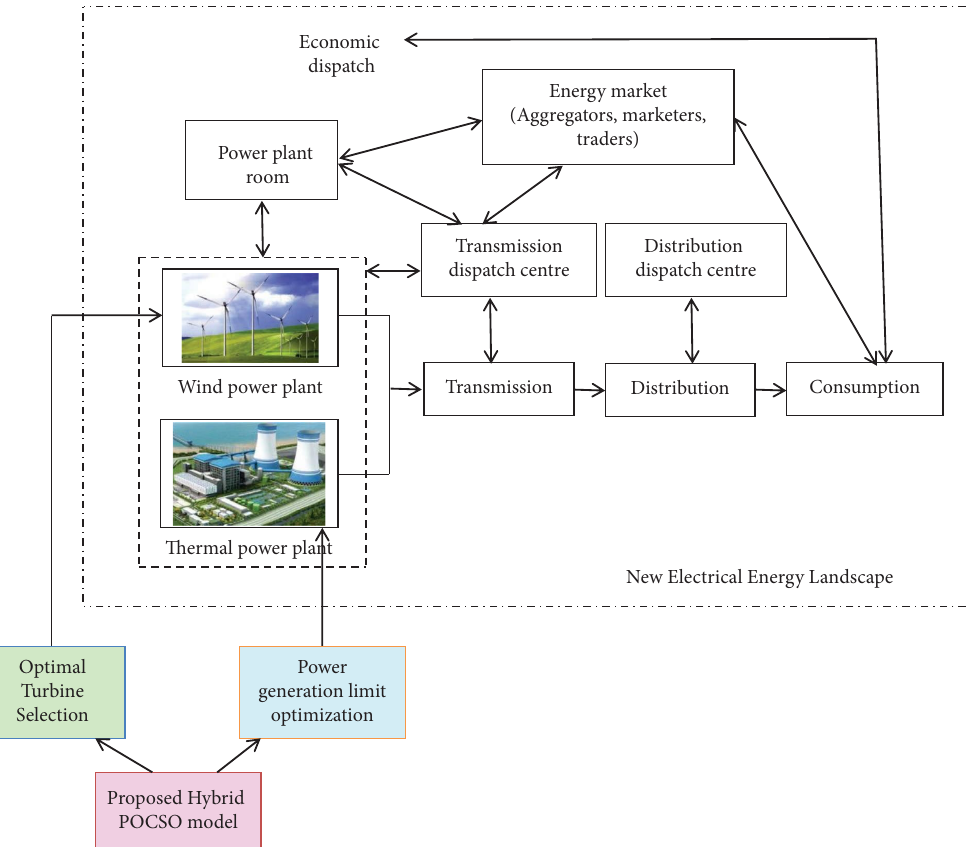
Figure 2: Overall architecture of the proposed work.